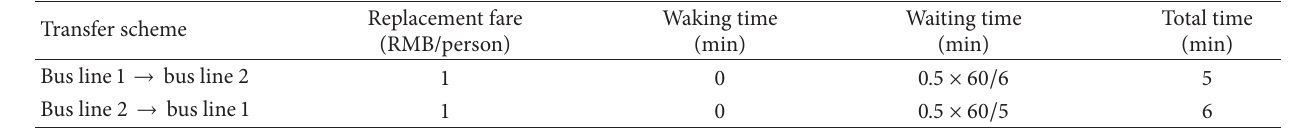
Table 4: Transfer information of bus system.